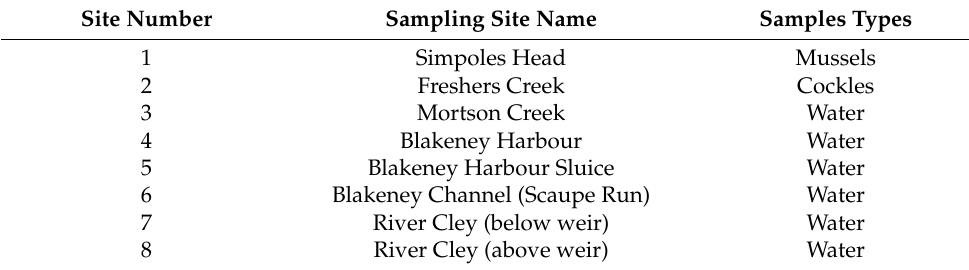
Table 1. Sampling site numbers, site name, and samples taken during the